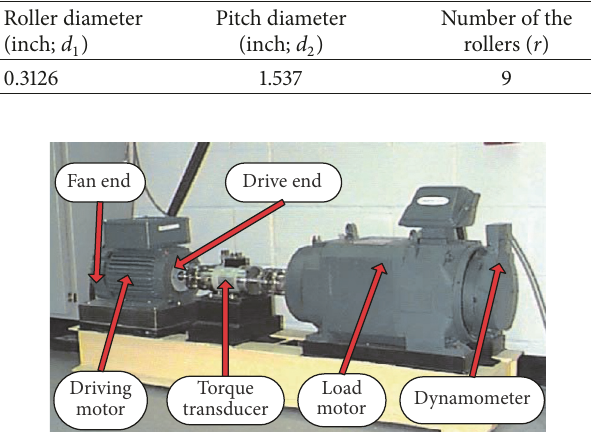
Figure 5: Frequency response analysis for SVVR.